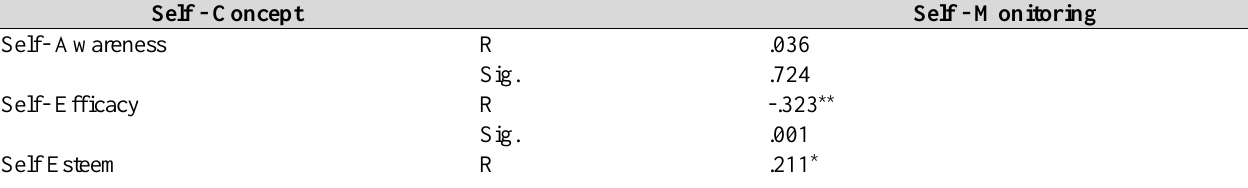
Correlation between Self Concept and